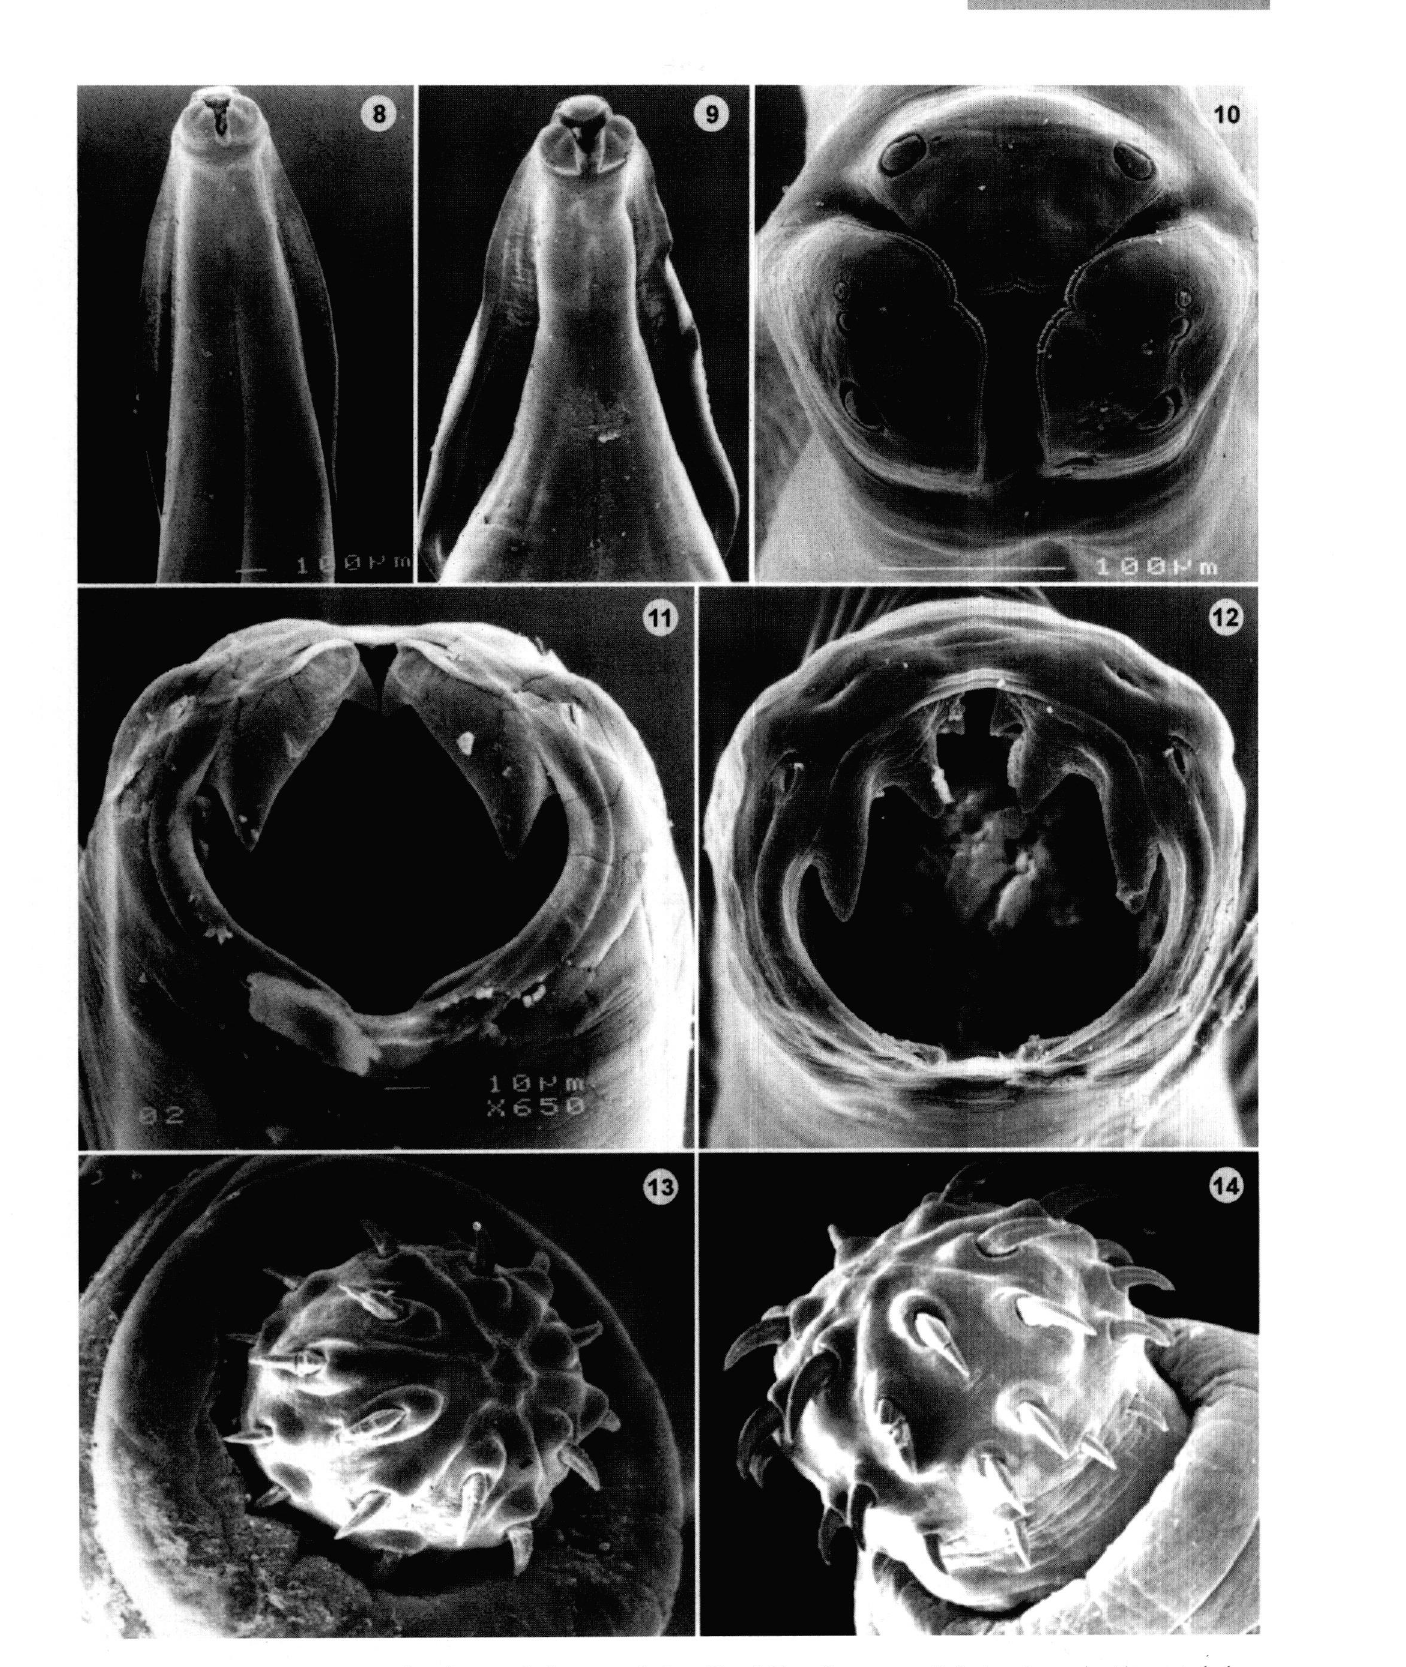
347 Parasite, 2003, 10, 343-350